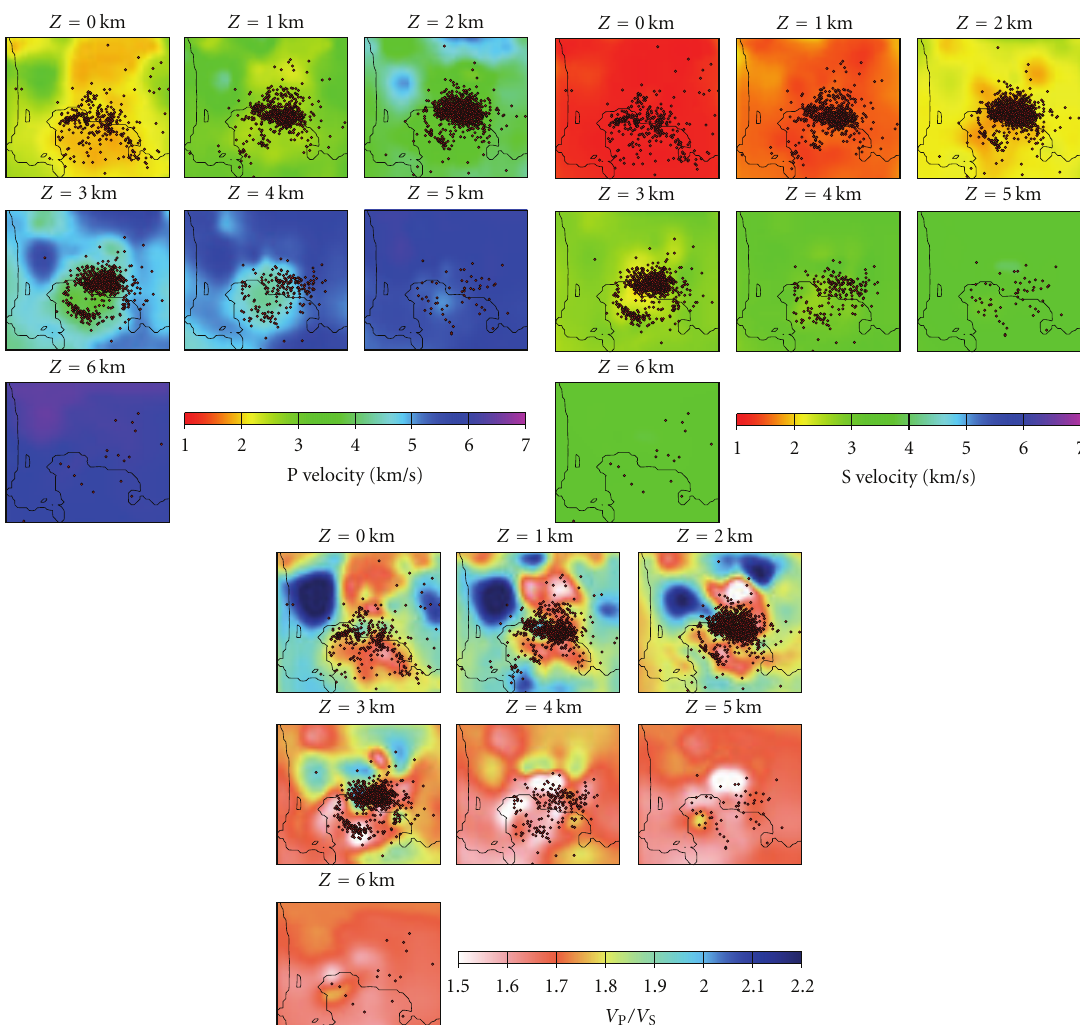
Figure 8: Similar to Figure 7, in this case for horizontal slices. To be compared to Figure 5. Axes scales are the